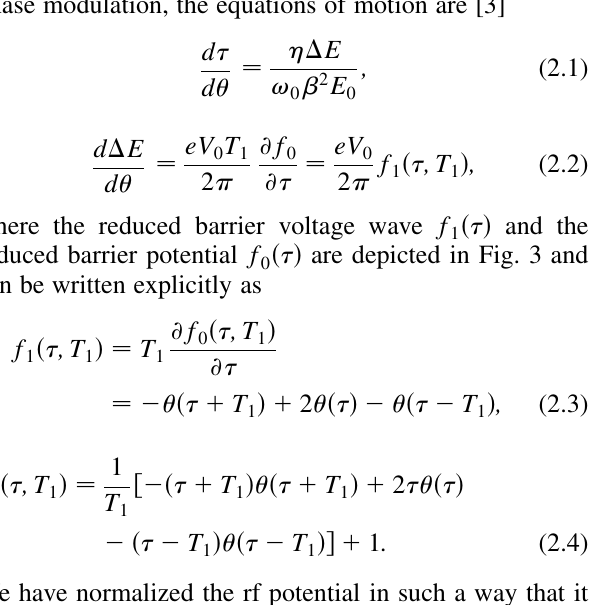
FIG. 3. Rf potential f